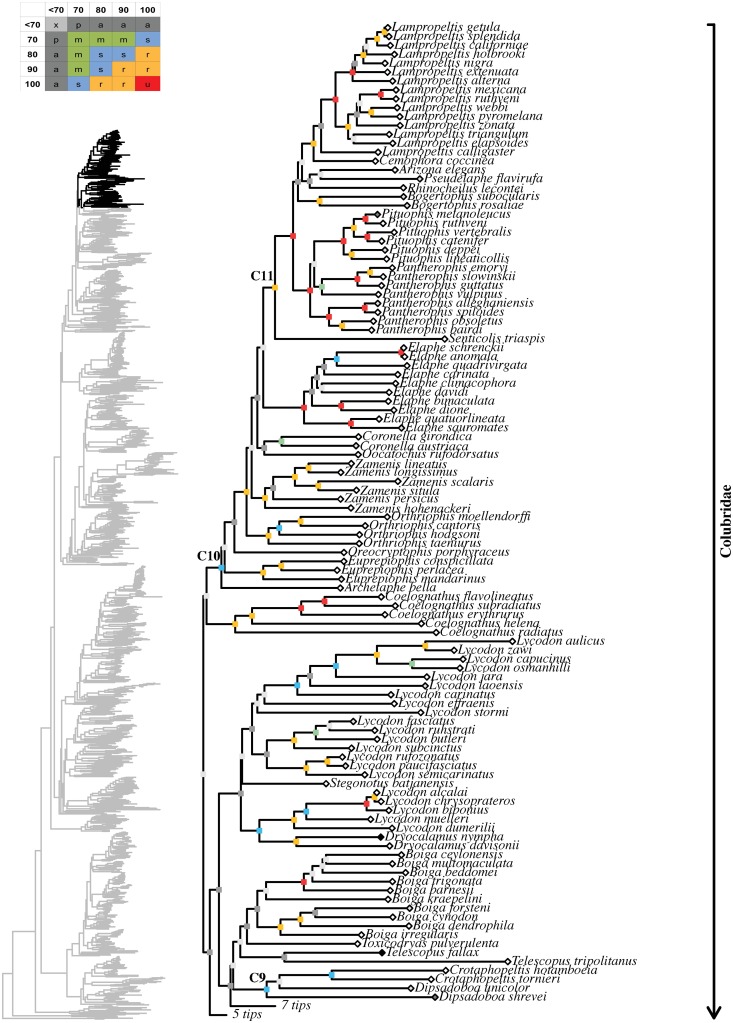
Maximum likelihood species-level phylogeny of Colubroides
(continued).Family Colubridae (continued).